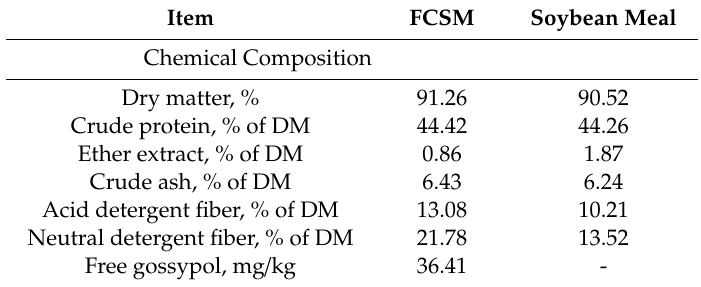
Table 2. Chemical composition, fatty acid and amino acid profile of FCSM and soybean meal 1